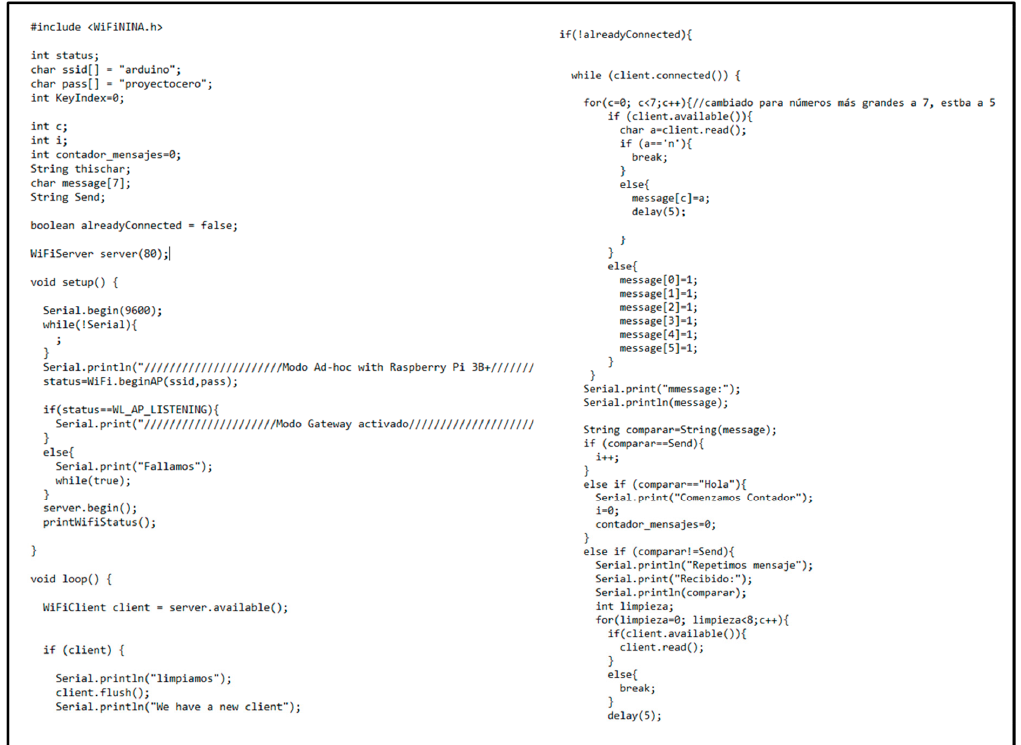
Figure A4. Arduino programming for embedded Wi-Fi, part 1 of 2.